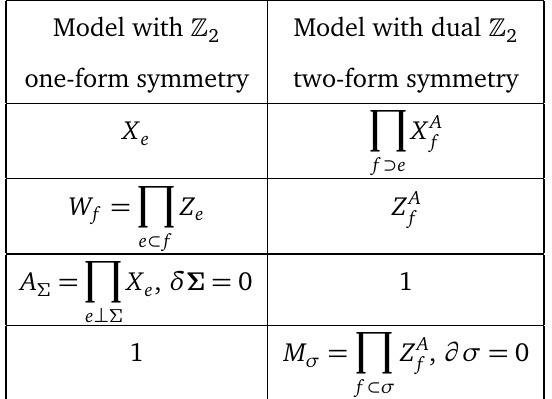
Table 1: In the process of gauging the one-form symmetry in 4d, the generators of local, 1-form symmetric operators are mapped according to the duality above. The symmetry operators A Σ , the product of X codimension-1 surface Σ , are mapped to the identity in the dual theory. The system on the right-hand side has a (cid:90) tors M σ , where σ is a closed 2d surface on the direct lattice.